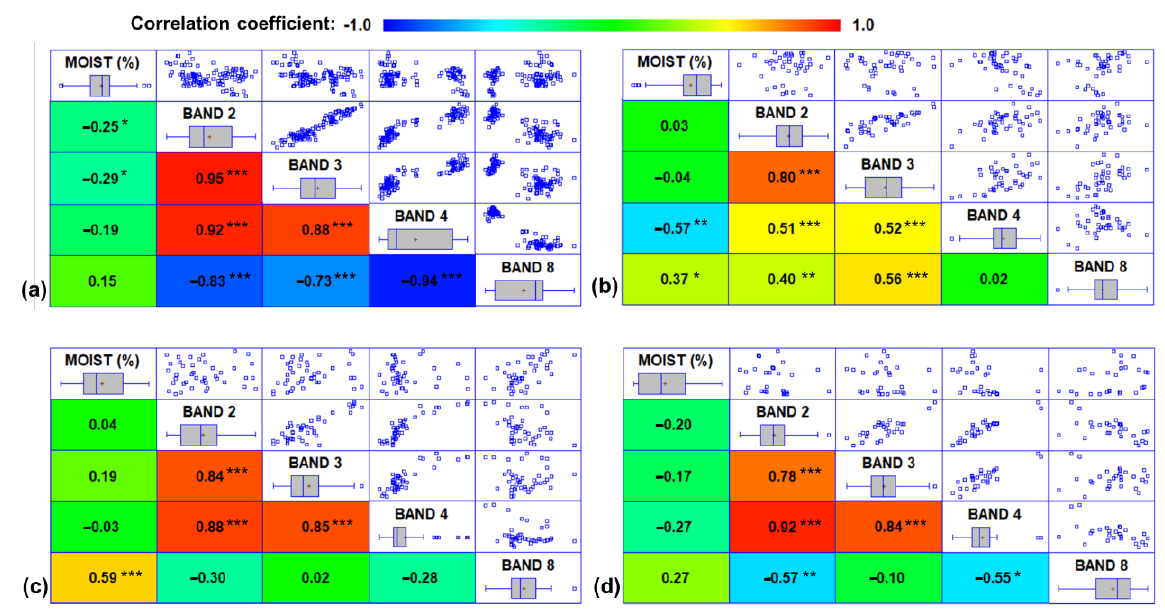
Figure 3. Summary of multivariate analyses. ( a ) all soil types, ( b ) clay soil, ( c ) sandy soil, ( d ) sandy-clay soil. Significance levels (Sig): *** p < 0.001; ** p < 0.010; * p <0.05.